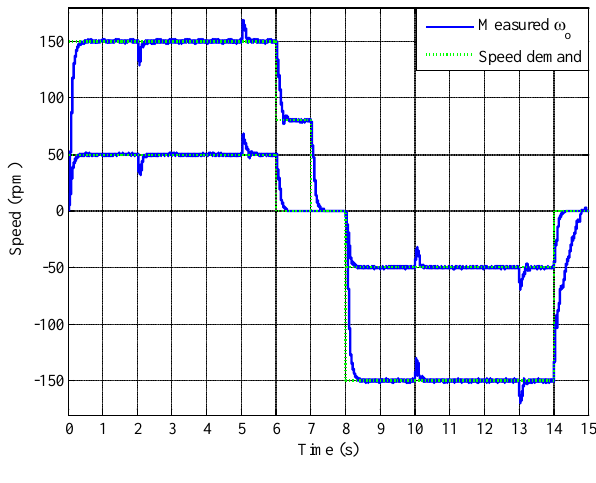
Figure 21. LSR under SFBK control and 100 Nm load